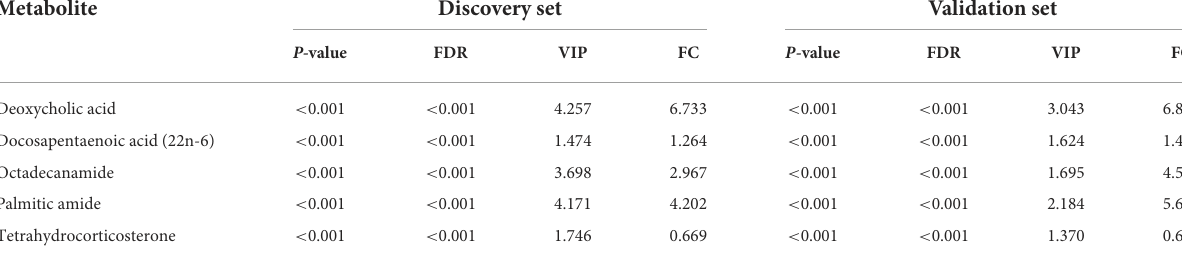
TABLE 2 Differentially altered metabolites identified between patients with CD and HCs.